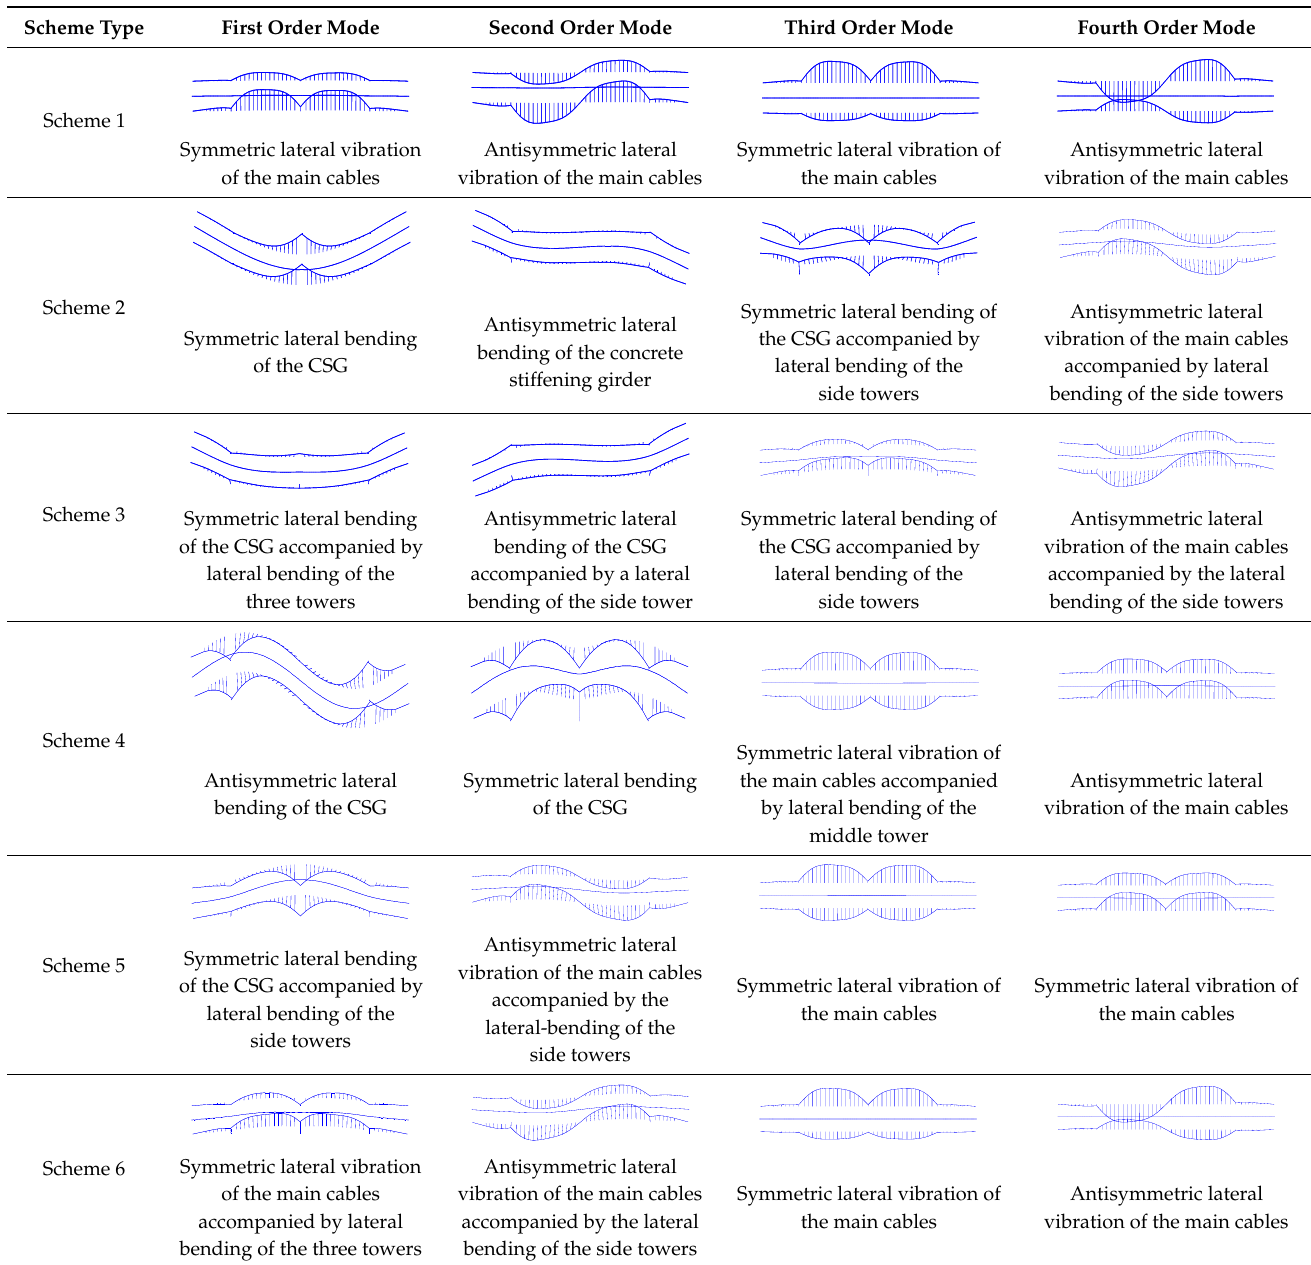
Table 3. The first four lateral vibration modes of the bridge with different layout schemes.